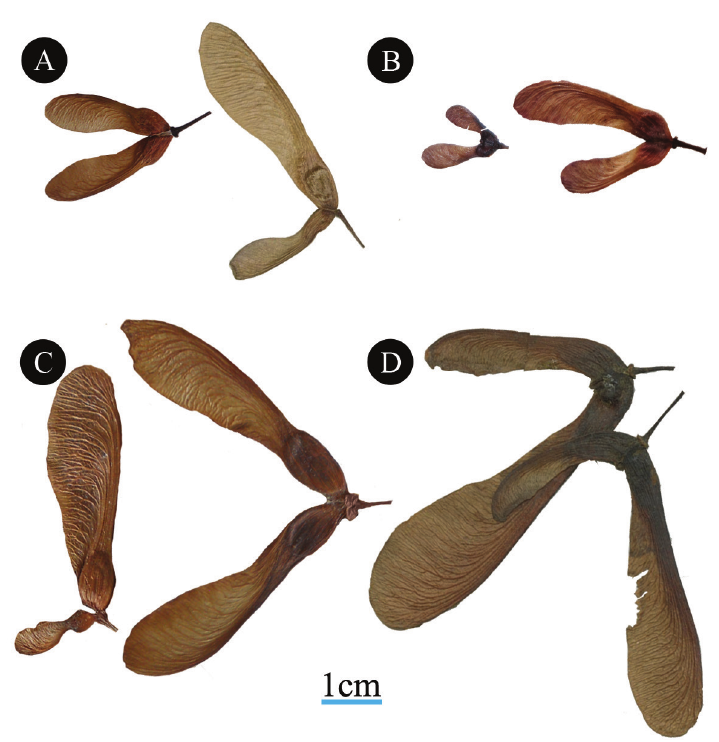
Figure 10. Fruits of species of Acer section Rubra . A A. rubrum . Specimen on left deposited at US National herbarium (US) with collection name and number: Lilian 62 . Specimen on right deposited at Kew (K) as Acer drummondii Nutt. (= A. rubrum ) with collection name and number: Drummond 53 . Im- age of fruits obtained from image of specimen deposited in JSTOR Plants (http://plants.jstor.org/) B A. pycnanthum , used with attribution to Chinese Virtual Herbarium(http://www.cvh.ac.cn/); Miyoshi Furuse 54050 , PE C A. saccharinum showing fruit with two fertilized ovules (upper) compared with one fertilized ovules and one partially developed, unfertilized ovule (lower). Specimens deposited at US with collection name and number: Wolf s.n. and Pringle s.n. , respectively D A. laurinum Specimen deposited at K with collection name and number: Lindley, 418 . Image of fruits obtained from image of specimen deposited in JSTOR Plants. Scale bar of 1cm applies to all